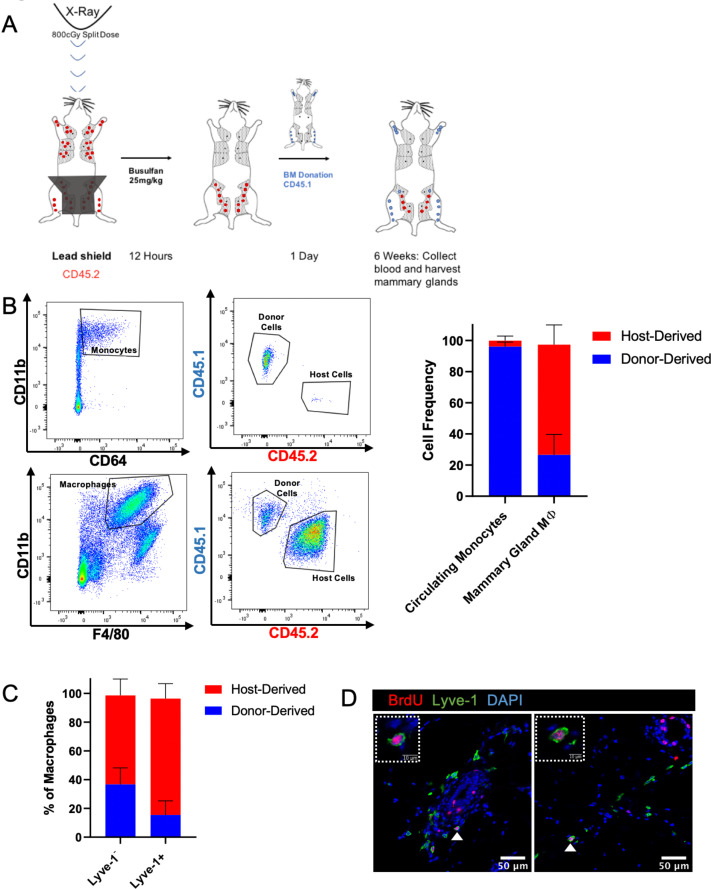
Lyve-1+ macrophages exhibit low turnover and self-renewal in the mammary gland.(A) Schematic of shielded bone marrow chimera experiment. (B) Representative flow cytometry plots showing the gating and identification of host (CD45.2) and donor (CD45.1) cells in the blood and mammary gland. Quantification of flow cytometry demonstrates that although most of the monocytes in the blood are donor-derived, the majority of macrophages in the mammary gland are host-derived. Cells were first gated on Live and pan-CD45 expression. In the quantification graphs, n = 23 mice from three separate experiments. (C) Quantification of flow cytometry demonstrates that the majority of Lyve-1+ macrophages remain host-derived 6 weeks after bone marrow transplant. (D) Mammary glands were isolated from mice after a 2 hr BrdU pulse and immunostained for BrdU and Lyve-1 (n = 3, three images/localization). Examples of BrdU+Lyve-1+ cells are shown, insets show higher magnification.Figure 4—source data 1.Source data for graphs in panels B and C.